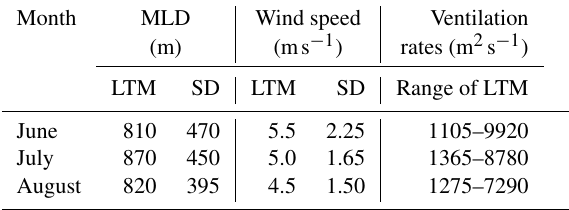
Table 1. Monthly long-term means (LTMs) and Sds of the mixing layer depth (MLD), wind speed, and range of ventilation rates over Beit Dagan in the central coast of the EM. LTM and SD values for (Dayan et al., 1988), and 1987–1989 (Dayan and Rodniski, 1999). LTM and SD values for wind speeds are from the NCEP/NCAR reanalysis project (NOAA-CIRES Climate Diagnostics Center) for a 51-year data record over 1948–1999 from http://www.esrl.noaa. gov/psd/ (adapted from Matvev et al.,